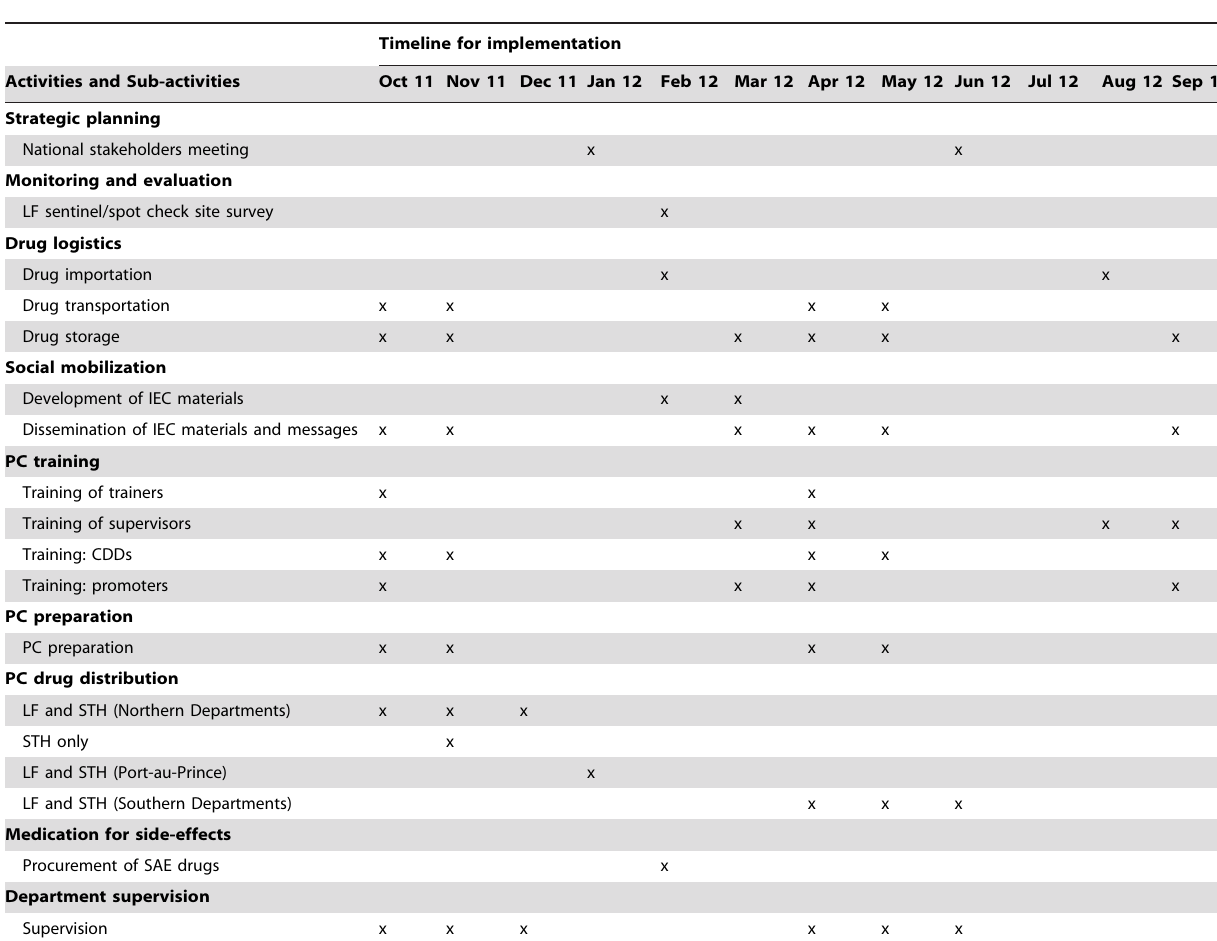
Table 7. Haiti annual work plan matrix and timeline (FY Oct. 2011–Sept.